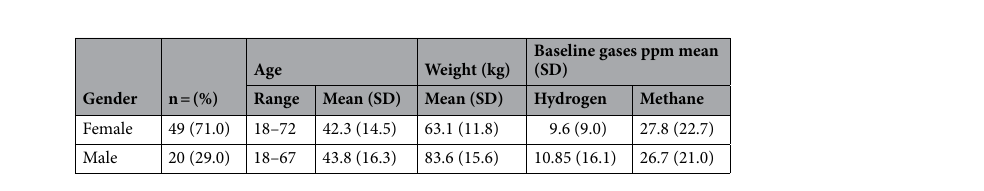
Table 3. Baseline characteristics of cohort (n =